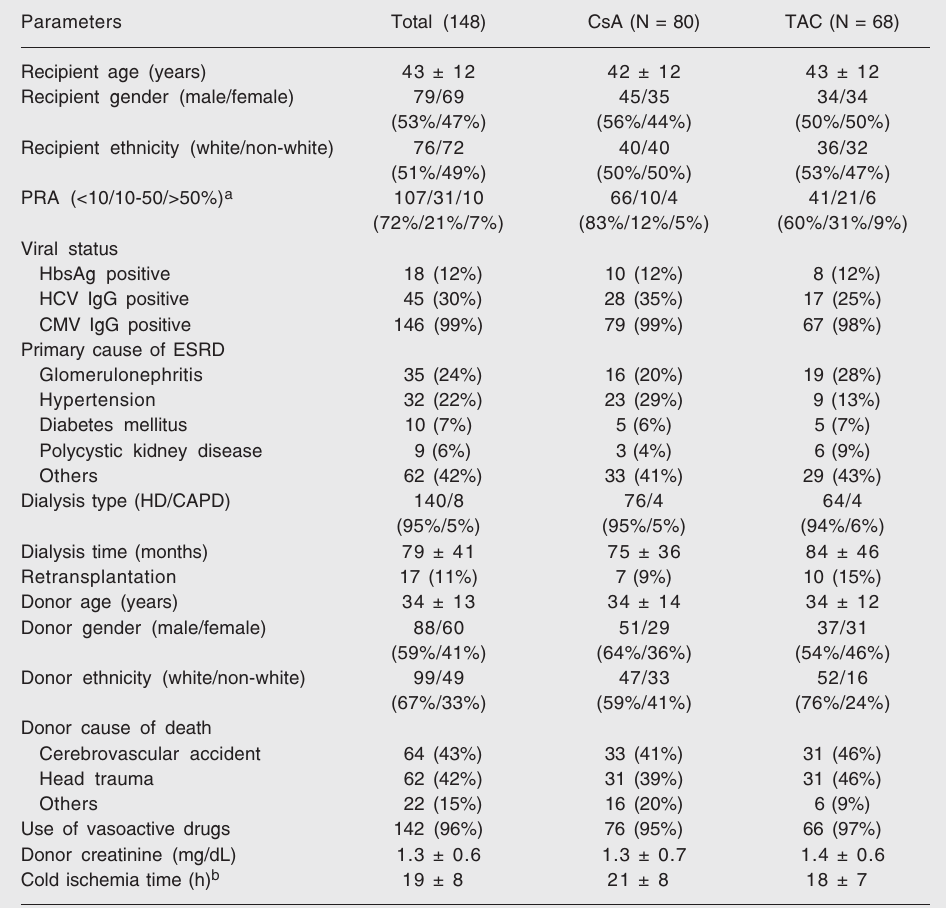
Table 1. Demographic characteristics of renal transplant recipients and donors.